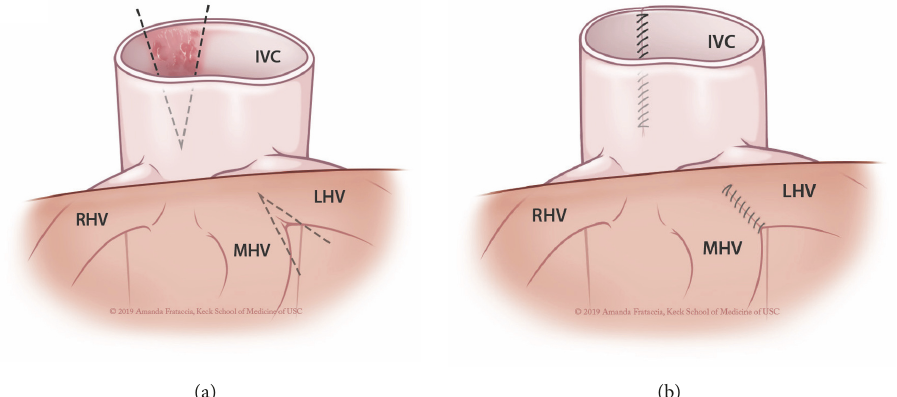
Figure 3: Method of venoplasty for removal of CVC cast in donor IVC prior to transplantation. Panel (a): anterior view of the native donor suprahepatic caval anatomy prior to venoplasty, with an area of inflammation and calcification due to foreign body reaction. Panel (b): anterior view postvenoplasty, demonstrating the areas of the IVC and MHV/LHV junction that were repaired to improve venous outflow and the overall integrity of the suprahepatic caval anastomosis.